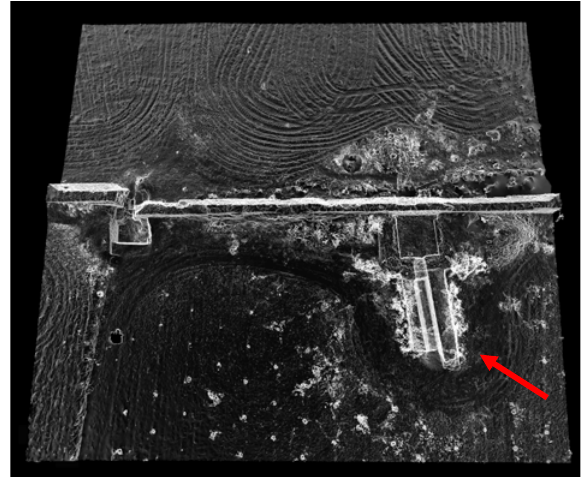
Figure 6. Render of 3D mesh of area of Roman Dam captured with TLS (Meshlab’s x-ray shader applied to mesh to better show subterranean structure, red arrow)